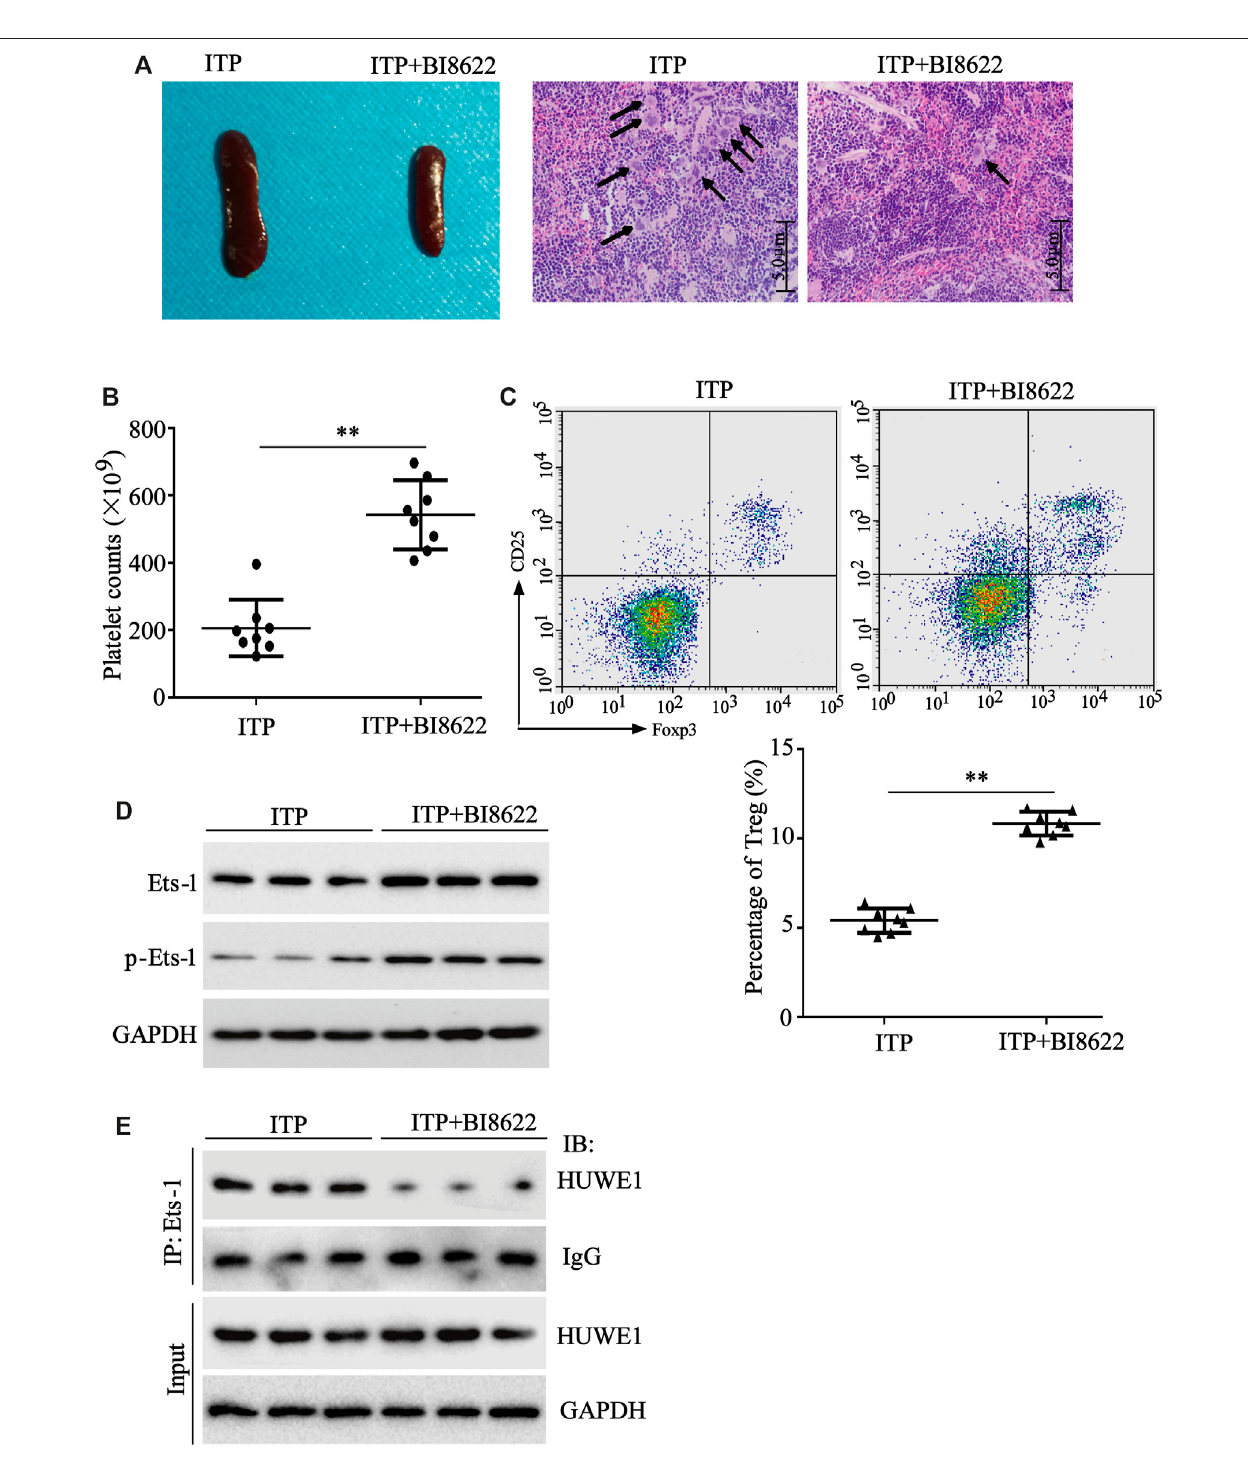
FIGURE7| ThefunctionofHUWE1 inhibitor on ITPmice.0.1 mg/kg HUWE1-speci fi cinhibitor BI8622 wasintraperitoneally injected intomice during ITPmodeling (three times a week). Sixteen male C57BL/6J mice (6 – 8 weeks old) were divided into the following two groups: ITP group and ITP + BI8622 group, and eight mice were randomly assigned to each group. (A) Hematoxylin-eosin (HE) staining was performed to analyze the pathological changes of the spleen in ITP mice (scale bar: 5.0 μ m), n (cid:2) 8. (B) Analysis of platelet counts in ITP mice (mean ± SEM, n (cid:2) 8). (C) Flow cytometry was conducted to analyze the percentage of Treg cells in spleens of ITP mice (mean ± SEM, n (cid:2) 8). (D) After the CD4 + T cells were isolated from the spleen cells of ITP mice, a Western blot was conducted to detect the protein levels of Ets-1 and p-Ets-1 in cells, n (cid:2) 3. (E) The interaction between HUWE1 and Ets-1 in spleen CD4 + T cells was con fi rmed using IP assay. ** p < 0.01 vs. ITP.